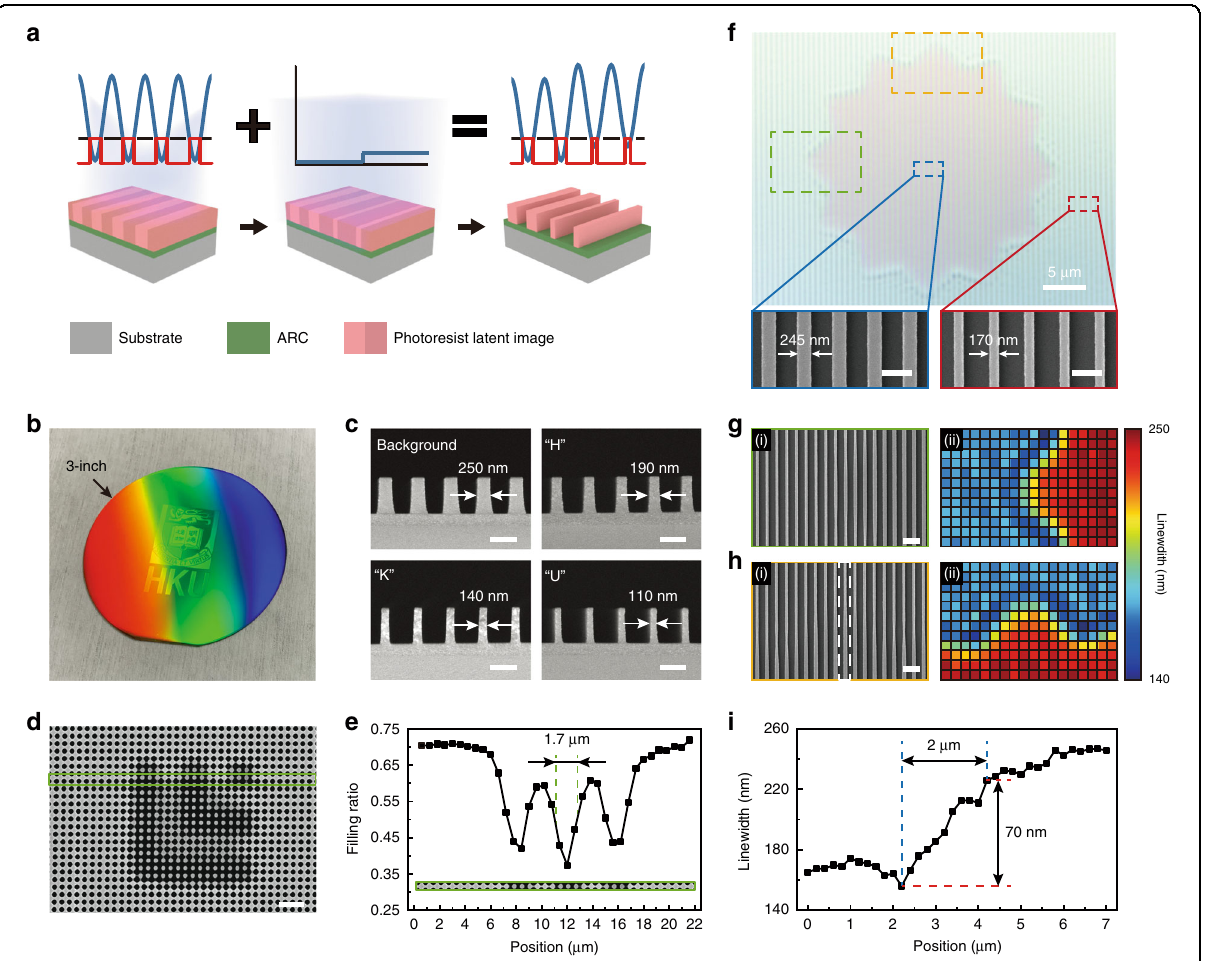
Fig. 3 Spatial modulation of nanostructure feature sizes using grayscale-patterned SE. a Schematic of spatial modulation of linewidth using patterned secondary exposure. b A 3-inch wafer carrying the HKU logo consisting of 600-nm-period photoresist gratings with the linewidths in different regions modulated by projected grayscale pattern. c SEM images taken on background, “ H ” , “ K ” , and “ U ” letters on the wafer, showing corresponding linewidths of 250, 190, 140, and 110 nm. d SEM image of a 600-nm-period hole array modulated by DLW secondary exposure. e Plot of the fi lling ratio of nanostructures in the green box in d versus the horizontal position, showing a resolution of 1.7 µm. f Optical microscope image of a 12-point-star pattern, consisting of 600-nm-period gratings with linewidths modulated by contact photolithography using a photomask. SEM images taken inside and outside the secondary exposure pattern, showing the 245-nm and 170-nm linewidths, respectively. g Green box and h yellow-box regions in f , characterized by (i) SEM images and (ii) linewidth distributions. i The linewidth variation measured every 200 nm along a grating line (white, Fig. 3h), showing the grating linewidth gradient of 35 nm/µm. Scale bars, 500 nm ( c , f ), 1 µm ( g , h ), and 2 µm ( d